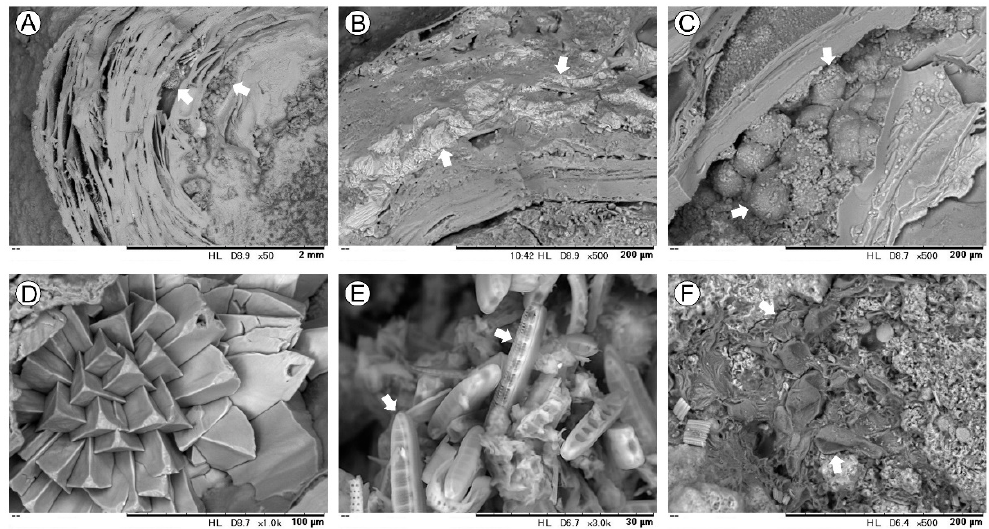
Figure 5. SEM images of the stalactite minerals. ( A ) cross-section (white arrows: carbonate minerals); ( B – D ) carbonate minerals between the rings of the silicate mineral; ( E ) diatoms; ( F ) green algae.